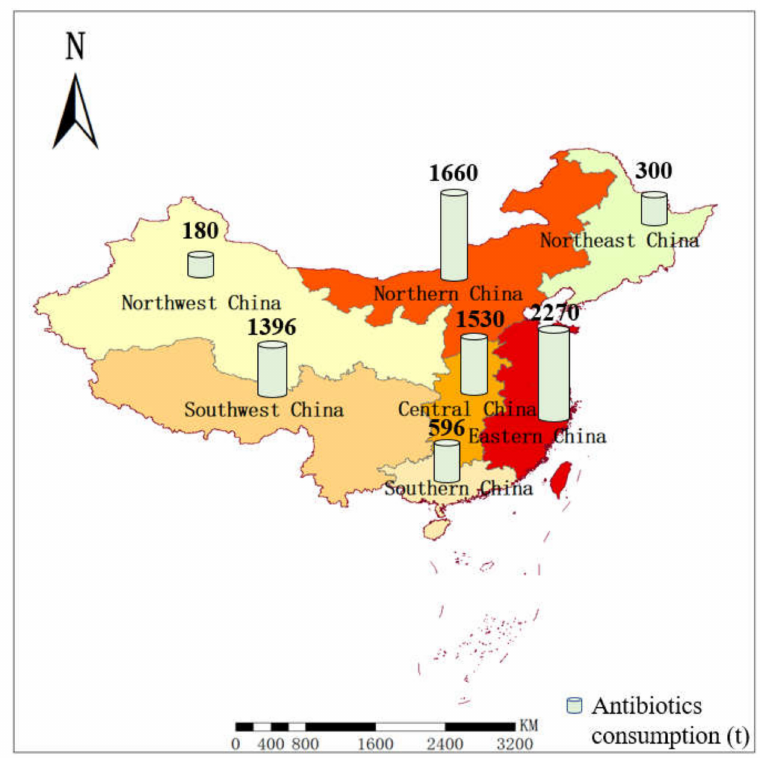
Figure 3. Consumption of antibiotics in different regions of China. Table 5. The concentrations of sulfonamides in domestic and foreign rivers